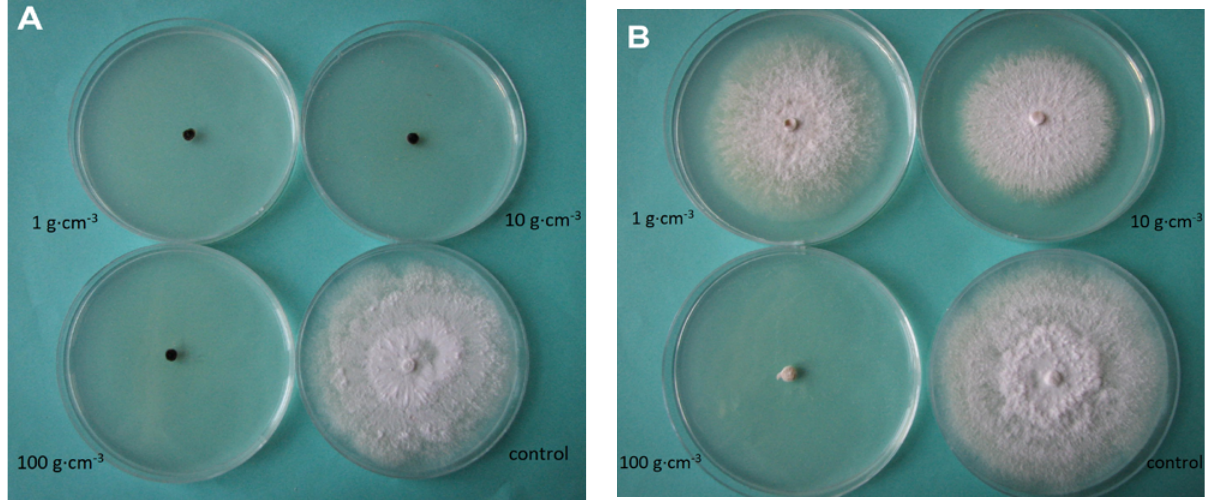
Fig. 1 Growth of Diaporthe eres (strain 264J) on PDA medium containing Topsin M 500 SC ( A ) and Sadoplon 75 WP ( B ) (photo B. Abramczyk).